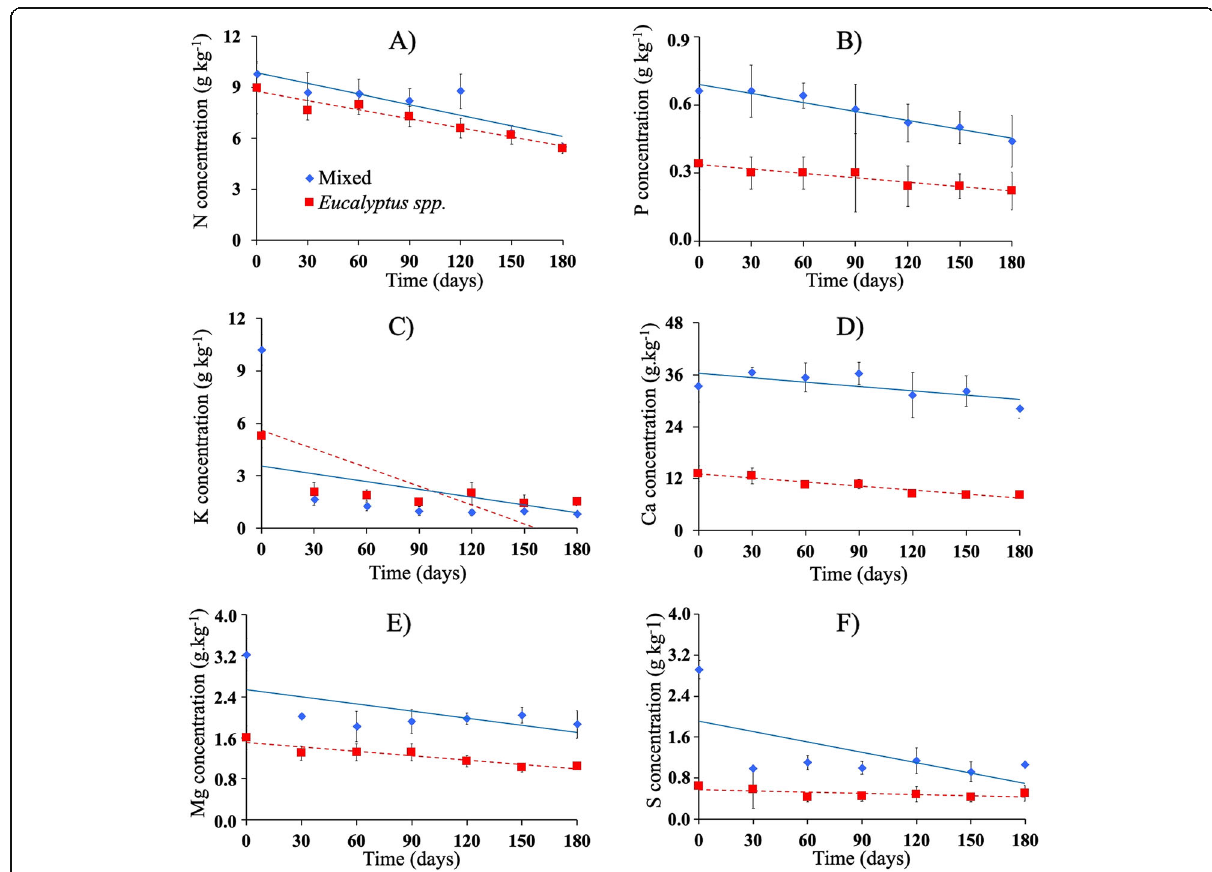
Fig. 3 Loss of macronutrients over time in mixed species (diamonds with blue lines) and Eucalyptus spp. (red squares with dotted lines). a Nitrogen loss, b phosphorus loss, c potassium loss, d calcium loss, e magnesium loss, f sulfur